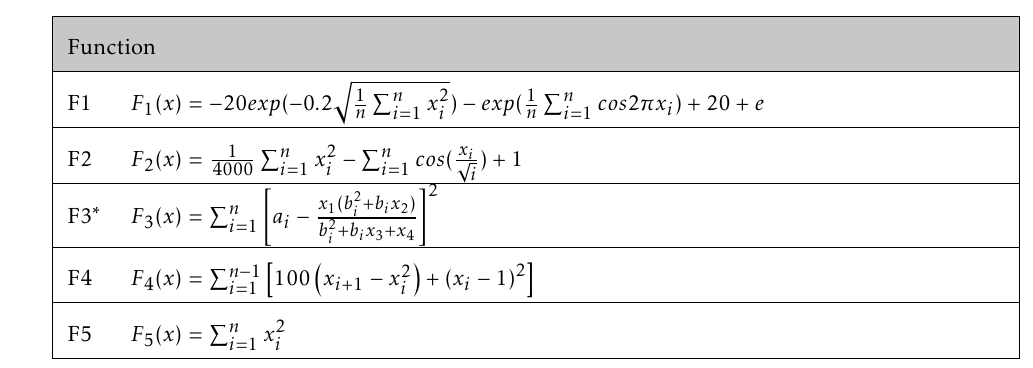
Table 3. Equations for the benchmark functions